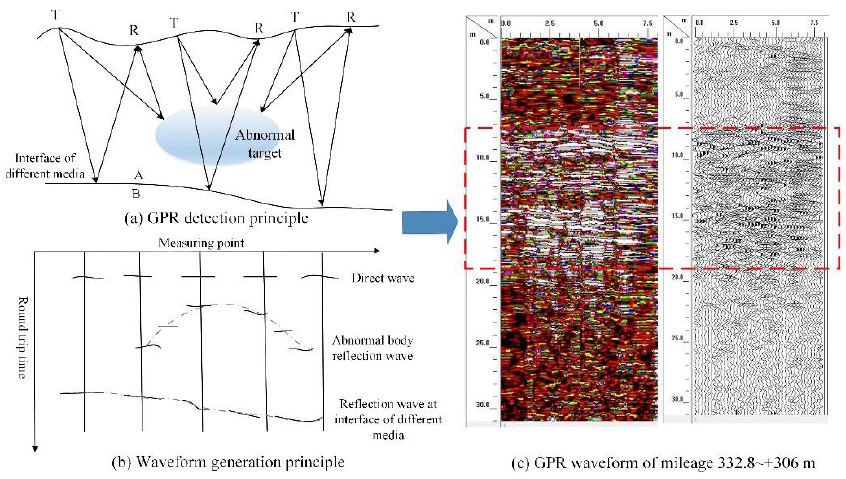
Figure 4. Mileage 325.6~+ 311 segment TSP output result.